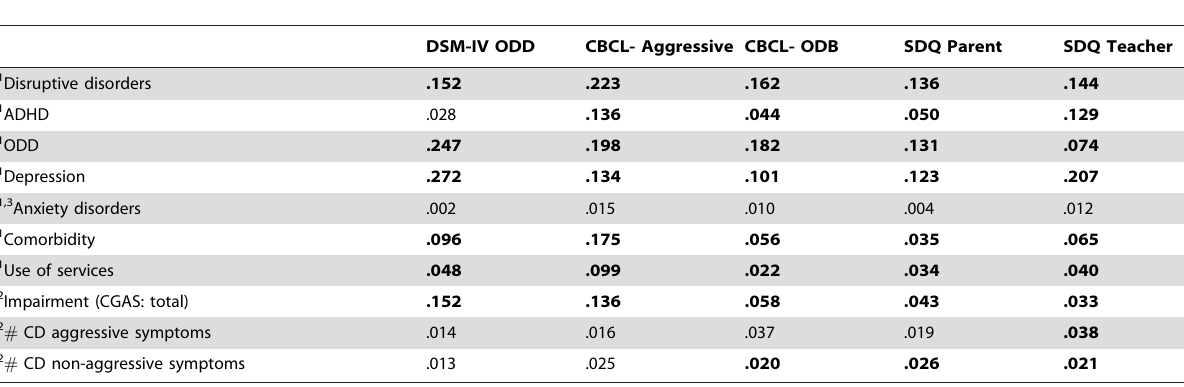
Table 2. Discriminative Ability of the Trajectories (columns) for outcomes (rows): Diagnoses, Comorbidity, Use of Services and Functional Impairment at Age 6 ( D R 2